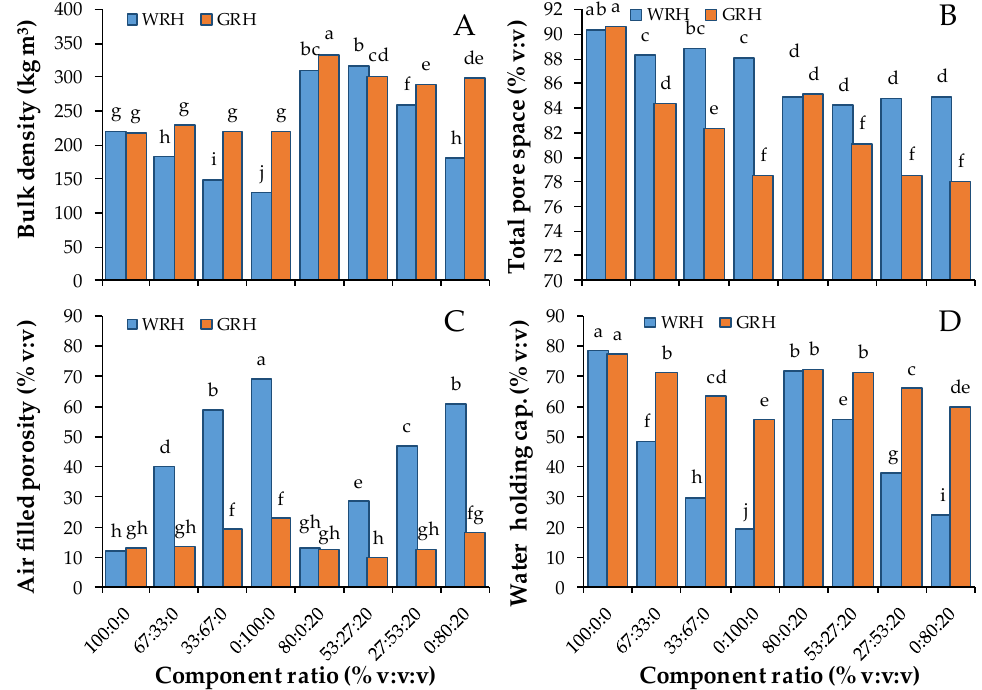
Figure 1. Interaction effects of the component ratio (P:RH:ADR % v:v:v) and rice hulls (RH) grinding (whole rice hulls and ground rice hulls, WRH and GRH) on: ( A ) bulk density; ( B ) total pore space; ( C ) air-filled porosity; and ( D ) water-holding capacity of the evaluated substrates. Significant differences among treatments are indicated by letter according to Tukey’s HSD test ( p < 0.05). P: peat; ADR: anaerobic digestion residues.